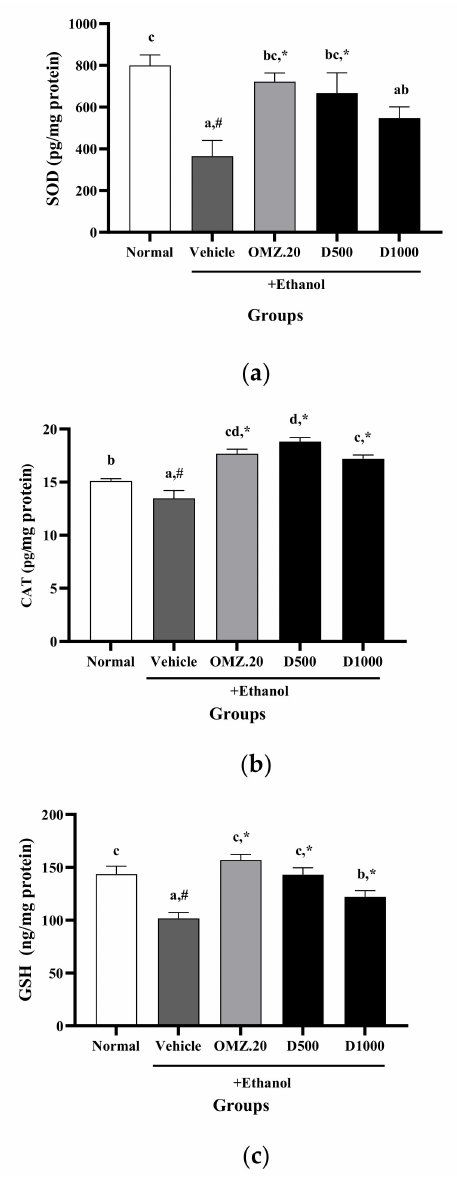
Figure 3. Effects of OMZ and Phy-Blica-D on the levels of SOD ( a ), CAT ( b ), and GSH ( c ) in the stomachs of rats exposed to ethanol. Data are expressed as the mean ± SEM ( n = 6 per group) and were analyzed using one-way ANOVA and Duncan’s post hoc multiple-comparison test. * Significantly different from the vehicle control at p < 0.05. # Significantly different from the normal group at p < 0.05. Different letters ( a–d ) indicate significant differences ( p < 0.05) between treatments determined by Duncan’s multiple-range